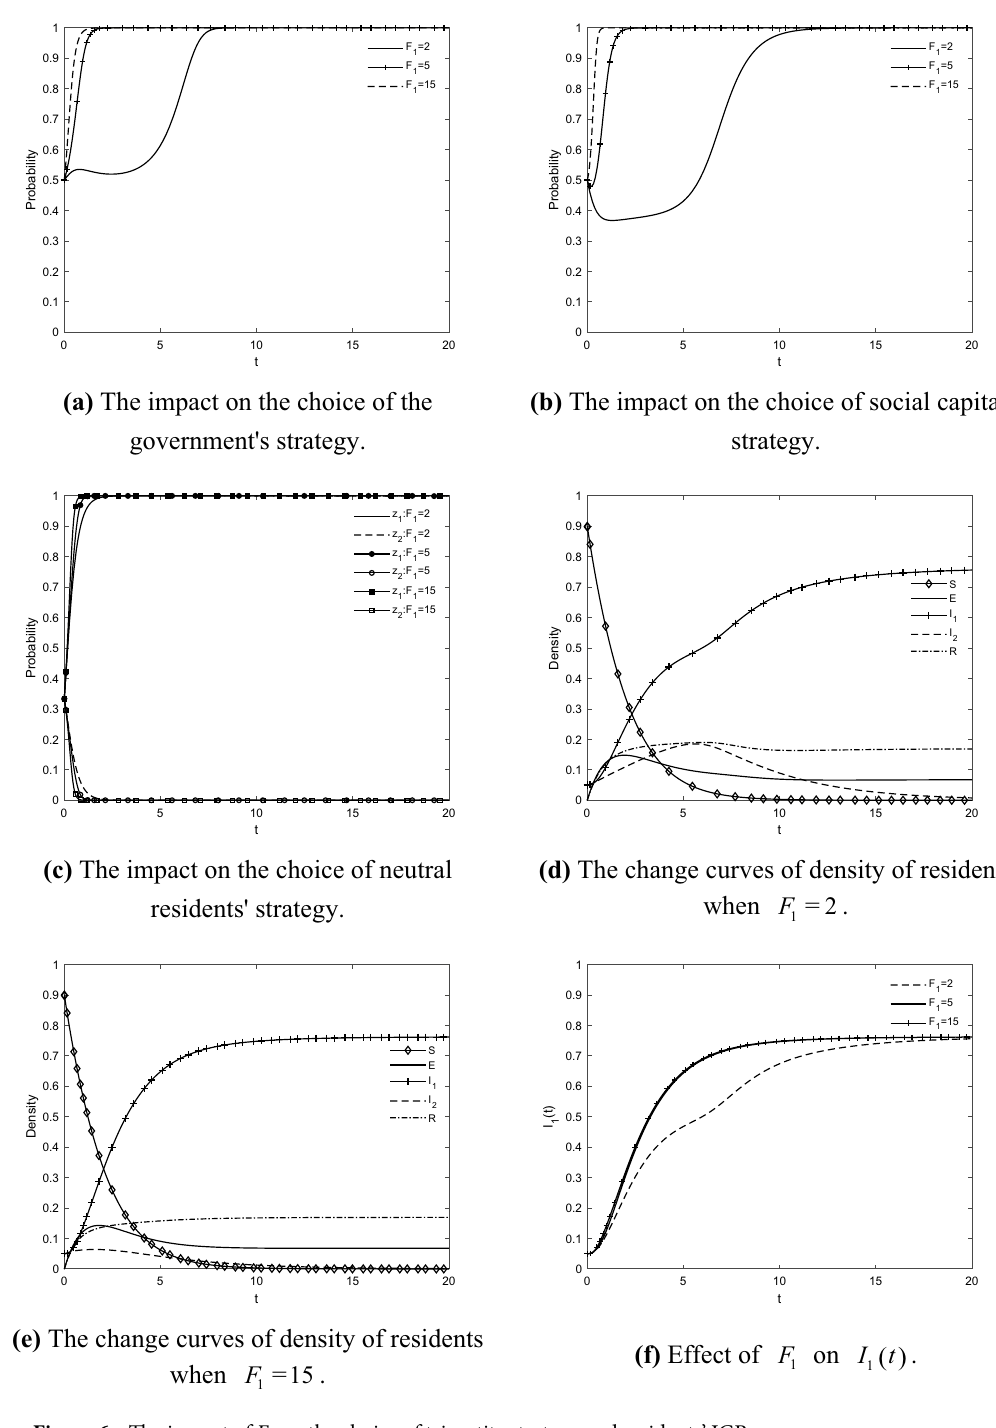
Figure 6. The impact of F 1 on the choice of tripartite strategy and residents’